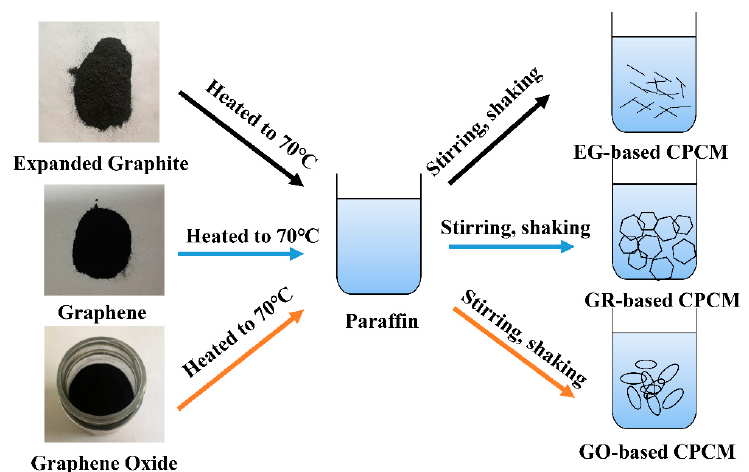
Figure 2. The preparation system of composite phase change materials (CPCM).